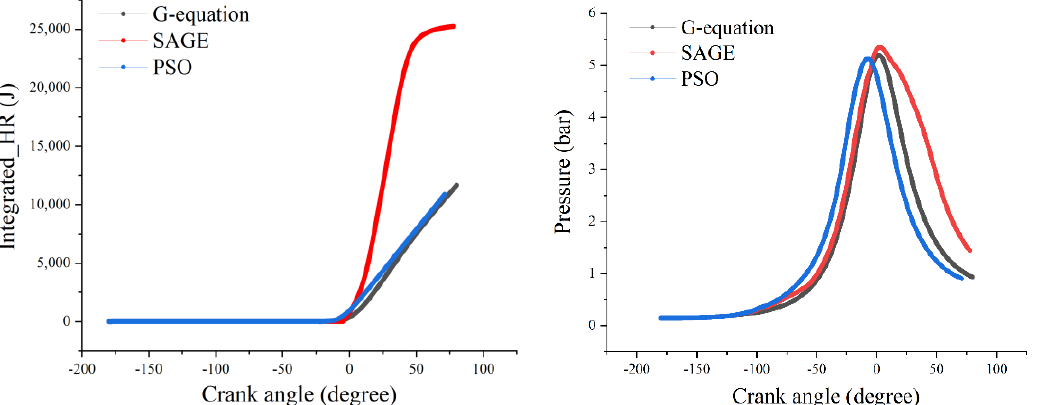
Figure 5. Integrated amount of heat release and pressure trace in the main chamber.